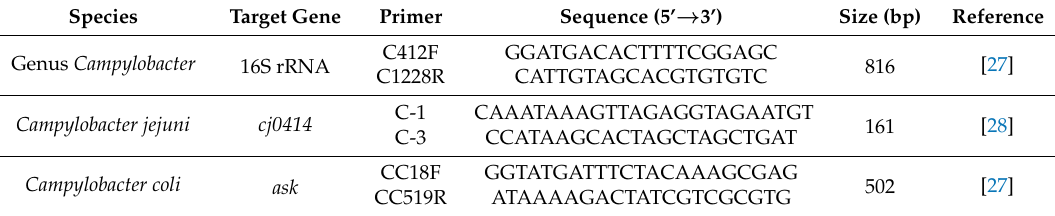
Table 1. Primer sequences used to identify the Campylobacter genus and